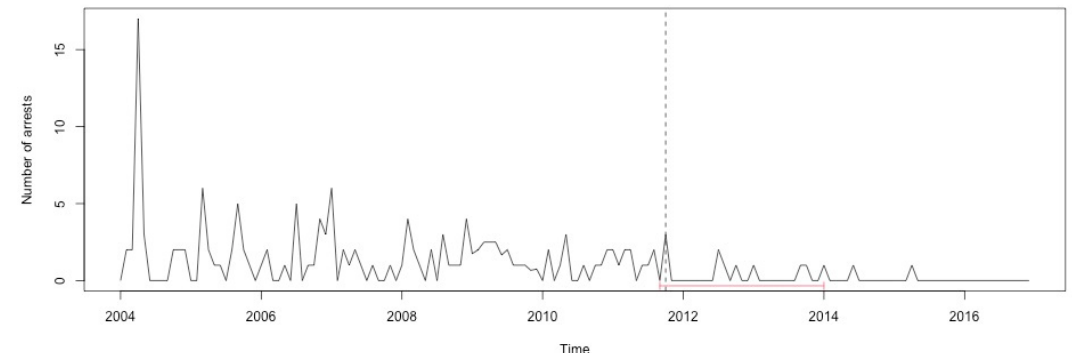
Figure A44. Heroin Vietnamese nationals arrests 2004–2016 in the Czech Republic and structural breaks.